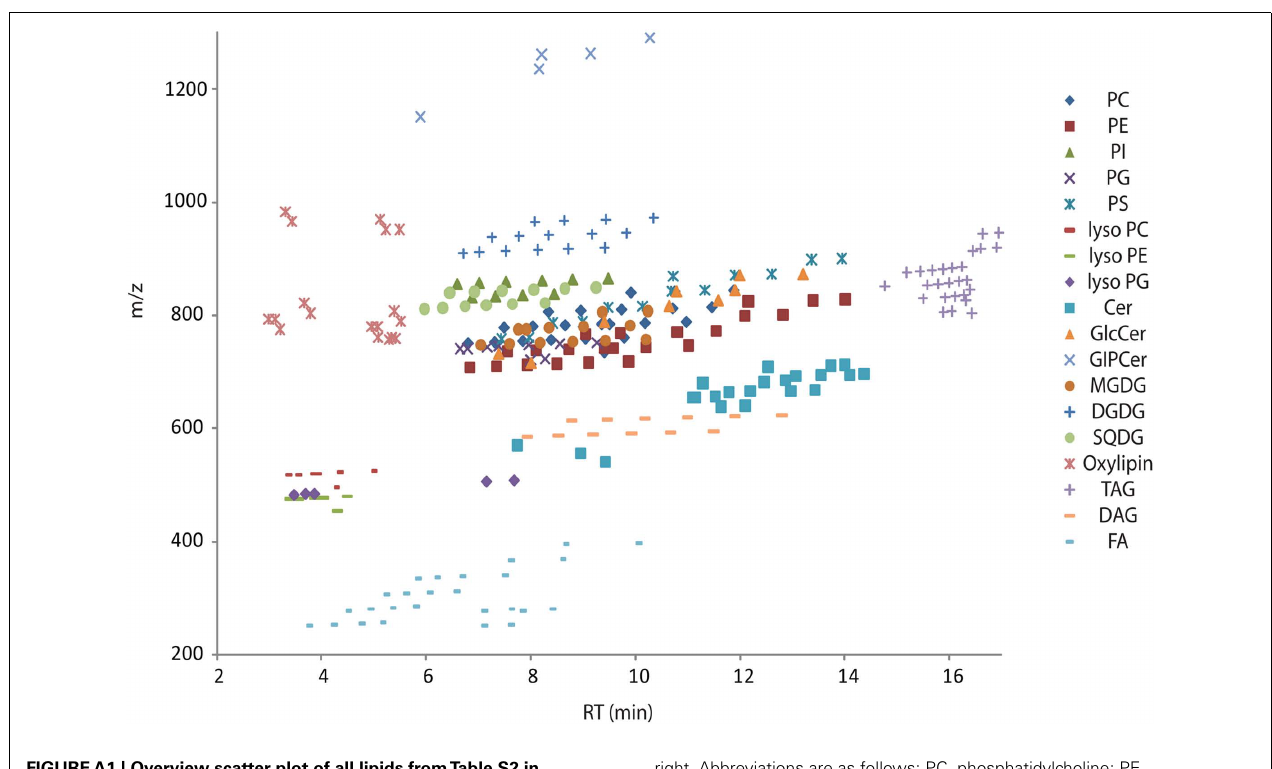
FIGUREA1 | Overview scatter plot of all lipids fromTable S2 in Supplementary Material .The plot contains the measured retention time in minutes on the x -axes and the recorded mass of the [M + H] + adduct on the y -axes. Due to the modular building block structure of lipids within a homogenous class, systematic patterns of parallel lines should be observed. From bottom to top these lines should contain lipids with increasing fatty acid chain length, while the number of double bond should decrease from left to